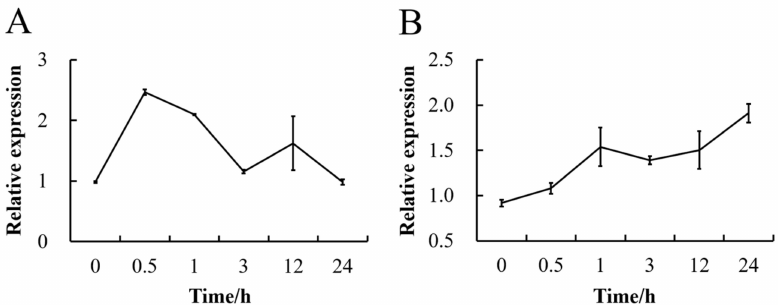
Figure 2. Change in expression level of the CmSWEET17 gene in response to exogenous sucrose treatment ( A ) in the leaf, and ( B ) in the axillary